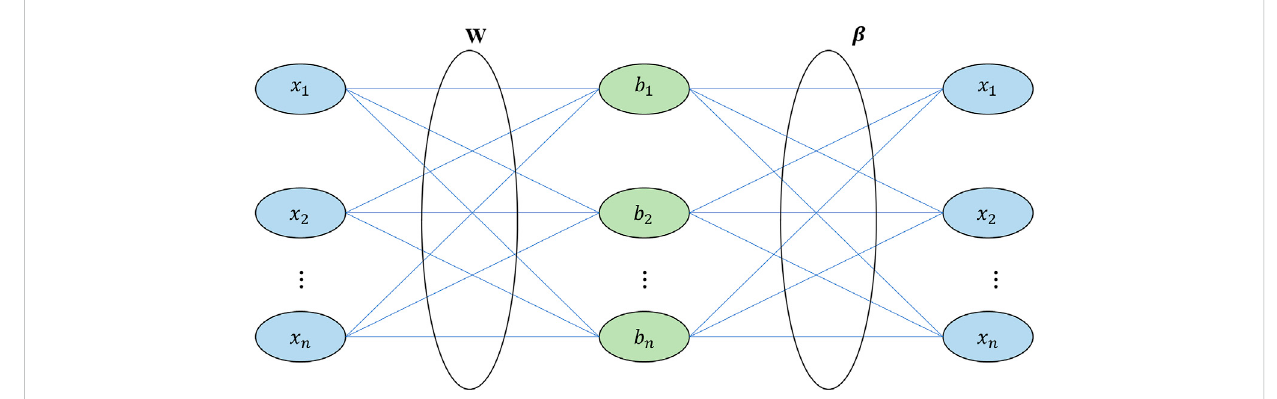
FIGURE 1 Structure of extreme learning machine. W is input weight, β is output